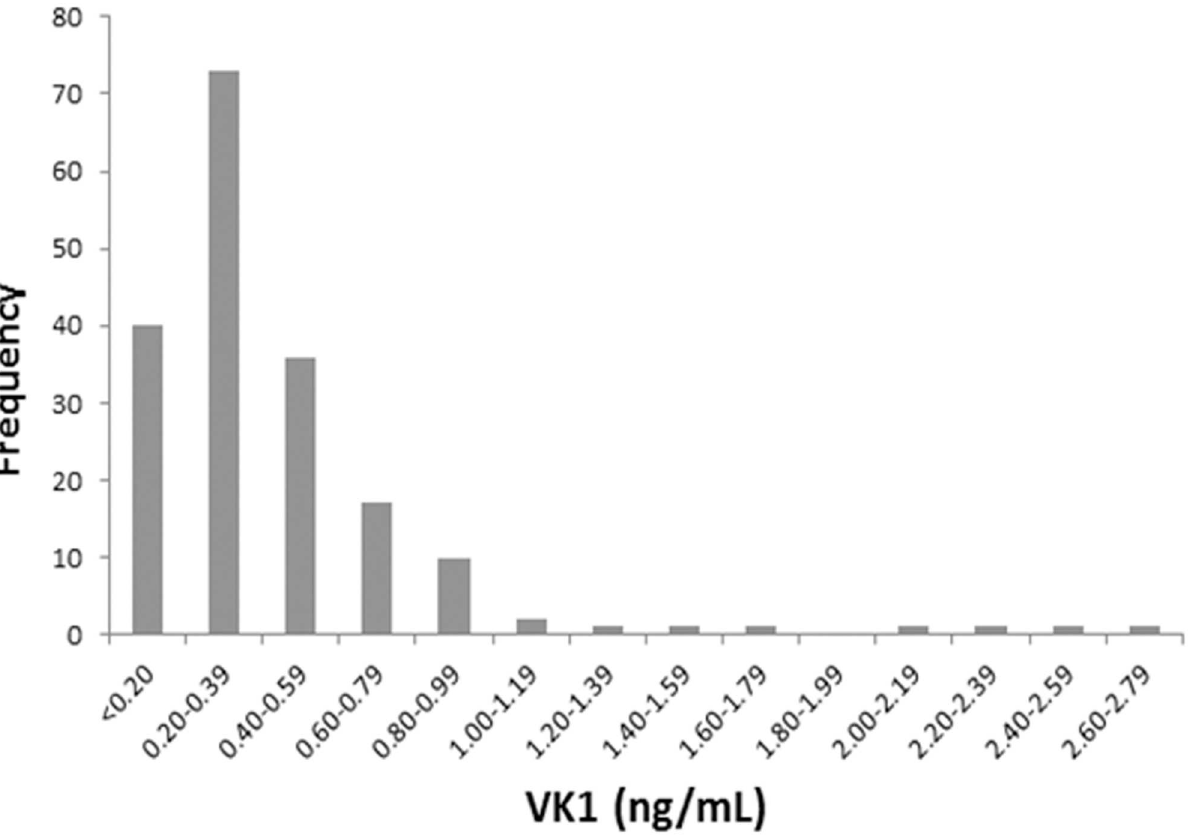
Fig 4. Frequency distribution of plasma VK1 concentration (N = 185). 20.5% of samples had VK1 concentrations of < 0.20 ng/ml.